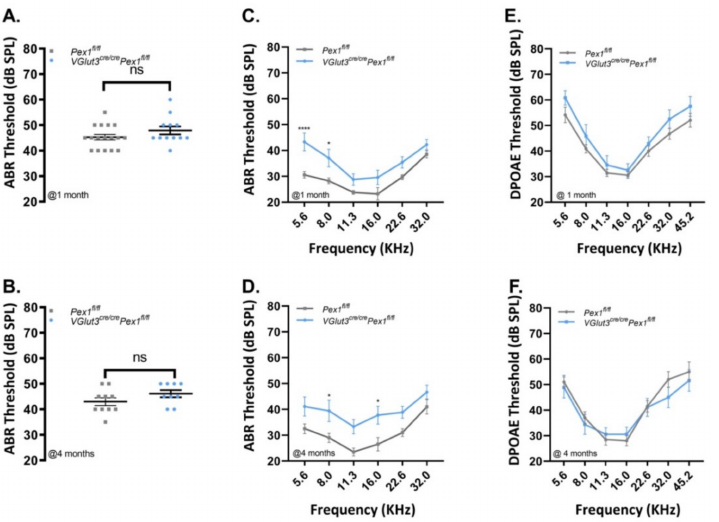
Figure 3. Mild hearing loss is observed in VGlut3 cre/cre Pex1 fl/fl mice . ( A , B ) Click ABR recordings